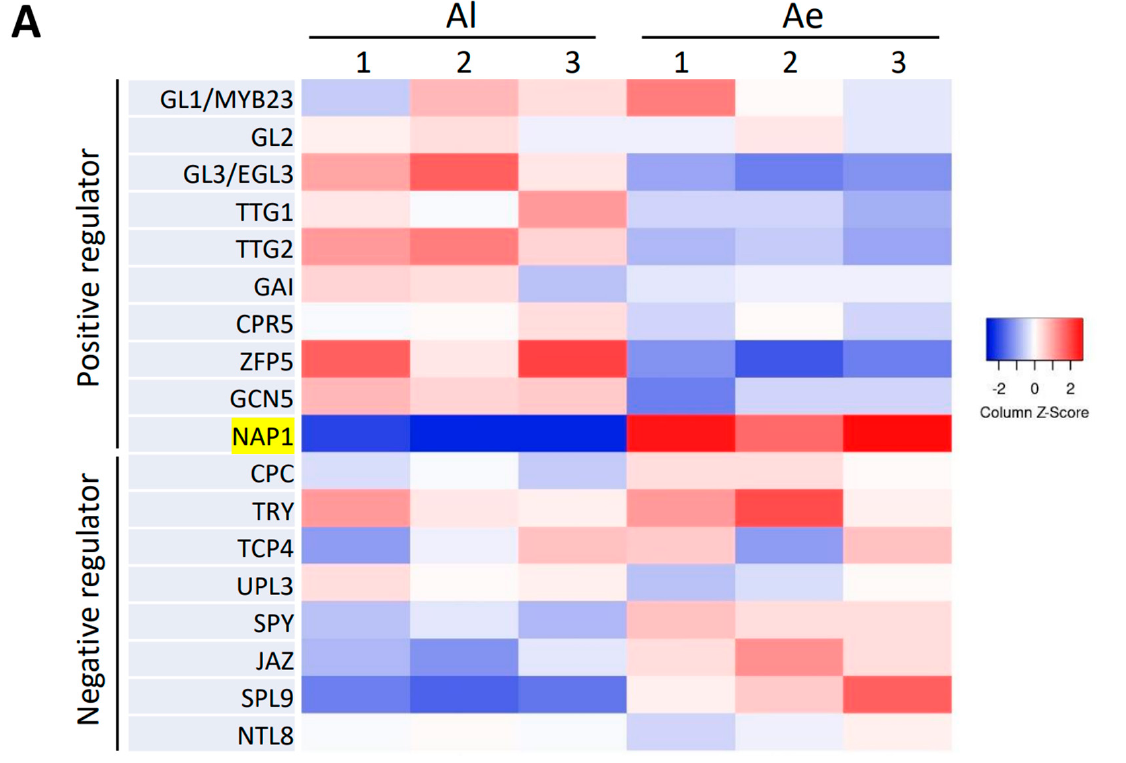
Figure 3. The expression levels and qRT − PCR veri fi cation of trichome-regulating genes in Al and Ae. ( A ) The expression levels of positive and negative regulators of trichome development in three replicates of RNA sequencing. ( B ) qRT − PCR analysis of these genes in Al and Ae. The relative ex- pression levels are shown in the mean values ± SD from three biological replicates. 2.3. Alternative Splicing of AlNAP1 mRNA To clone the NAP1 gene in kiwifruit, we used the samples for RNA-seq as a template and the same pair of primers targeting the 5 ′ and 3 ′ UTRs of both AeNAP1 (DTZ79_14g00610, accession number of Ae genome) and AlNAP1 to perform RT-PCR. The results showed that Ae has a clear band with the expected size (Figure 4A), while Al has two alternatively spliced bands, named AlNAP1-AS1 and AlNAP1-AS2 , in addition to the